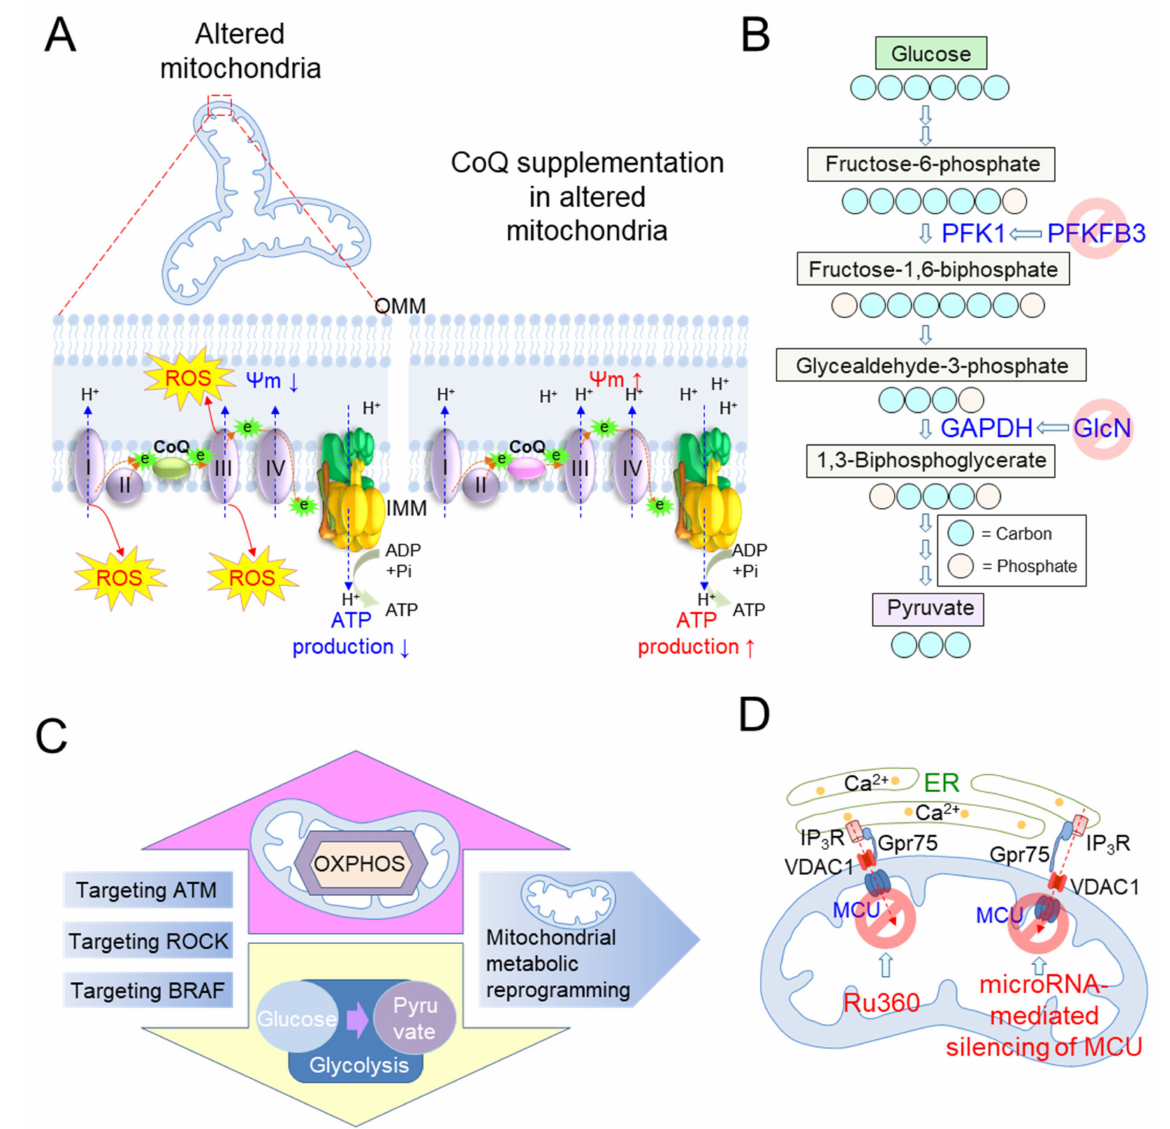
Figure 4. Targeting mitochondrial metabolism as a strategy to treat senescence. ( A ) Senescent cells exhibit a deficiency in coenzyme Q10 (CoQ), which accepts electrons from complex I/II and transfers them to complex III in the ETC (green CoQ indicates a deficiency in CoQ). Electrons that leaked from the ETC prematurely react with O 2 , causing excessive mitochondrial ROS production. A deficiency of CoQ reduces the efficiency of OXPHOS based on ∆Ψ m in flowing protons back to the mitochondrial matrix via ATP synthase, resulting in decreased ATP production. CoQ supplementation improves OXPHOS efficiency, which manifests as a significant increase in ATP production and a significant decrease in mitochondrial ROS generation (pink CoQ indicates a higher level of CoQ in the IMM). ( B ) PFKFB3 is a gene that encodes 6-phosphofructo- 2-kinase/fructose-2,6-biphosphatase 3, which activates phosphofructokinase 1 (PFK1), converting fructose-6-phosphate to fructose-1,6-bisphophate. Pharmacological inhibition of the glycolytic activator, PFKFB3, inhibits glycolysis and prevents the senescence-associated secretory phenotype (SASP)-mediated spread of senescence in endothelial cells (ECs). D-glucosamine (GlcN) inhibits the activity of glyceraldehyde-3-phosphate-dehydrogenase (GAPDH) in the glycolytic pathway. GlcN increases mitochondrial respiration by promoting the dependence of energy metabolism on OXPHOS while impairing glycolysis. ( C ) The strategy of targeting pathways directly or indirectly linked to mitochondrial metabolism. ATM: ataxia telangiectasia mutated; ROCK: rho-associated protein kinase; BRAF: serine/threonine protein kinase B-Raf. ( D ) The strategy of maintaining mitochondrial metabolism through mitochondrial Ca 2+ homeostasis. The cell-permeable MCU inhibitor, Ruthenium 360 (Ru360), maintains mitochondrial Ca 2+ at basal levels and improves OXPHOS efficiency. The inhibition of MCU by microRNA-mediated silencing also protects cardiomyocytes from oxidative damage and restores mitochondrial function